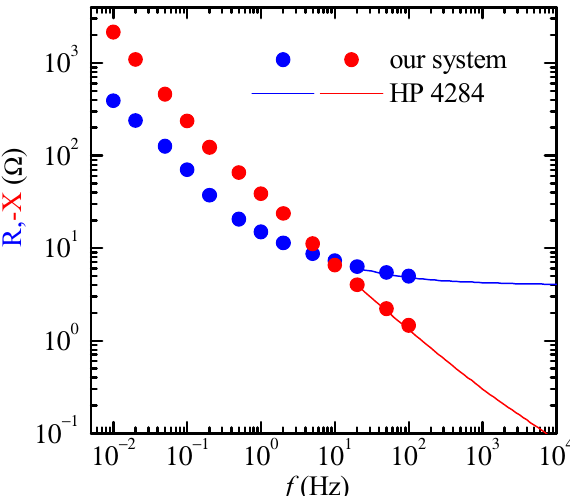
Figure 12. Real ( R ) and imaginary (X) part of the impedance of the device in Figure 11 as measured by the system proposed in this paper (symbols, from 10 mHz to 100 Hz) and as measured using an HP 4284 LCR meter (solid line, above 20 Hz).